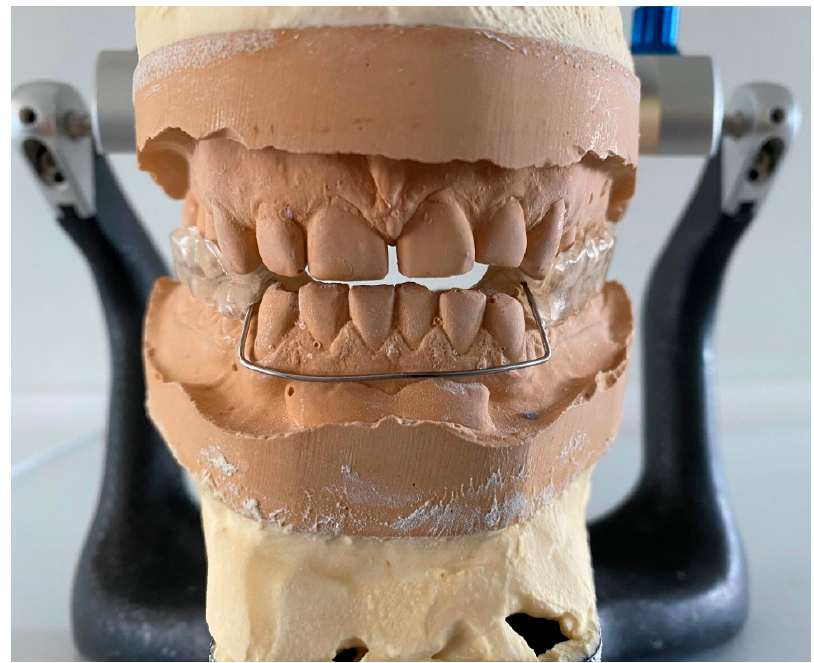
Figure 4. A bimaxillary splint.